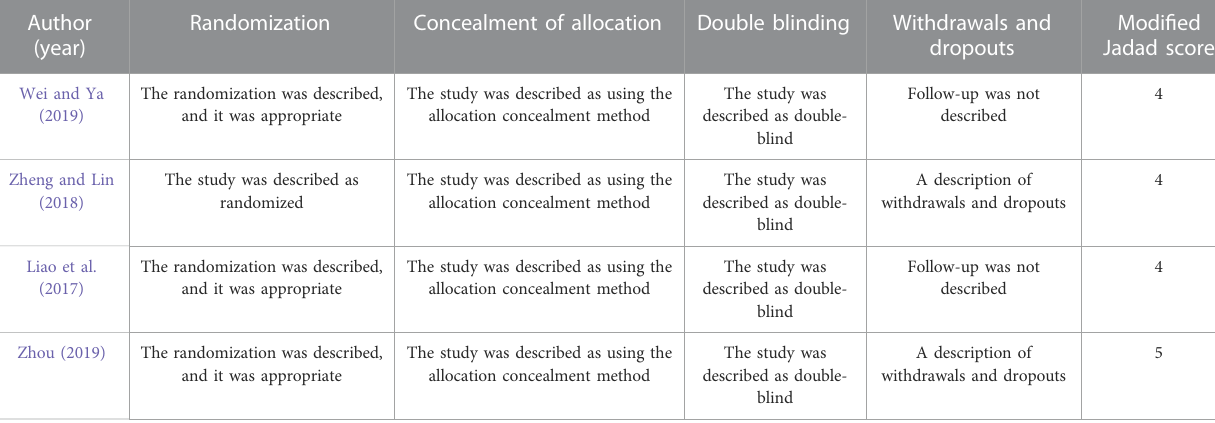
(Supplementary Figure S2). For in fl uence analyses, we performed an additional meta-analysis for each outcome after excluding one of the original studies. We found that every single excluded trial did not evidently affect the overall results (Supplementary Figure S3), suggesting that the results of the current meta-analyses were stable and reliable.